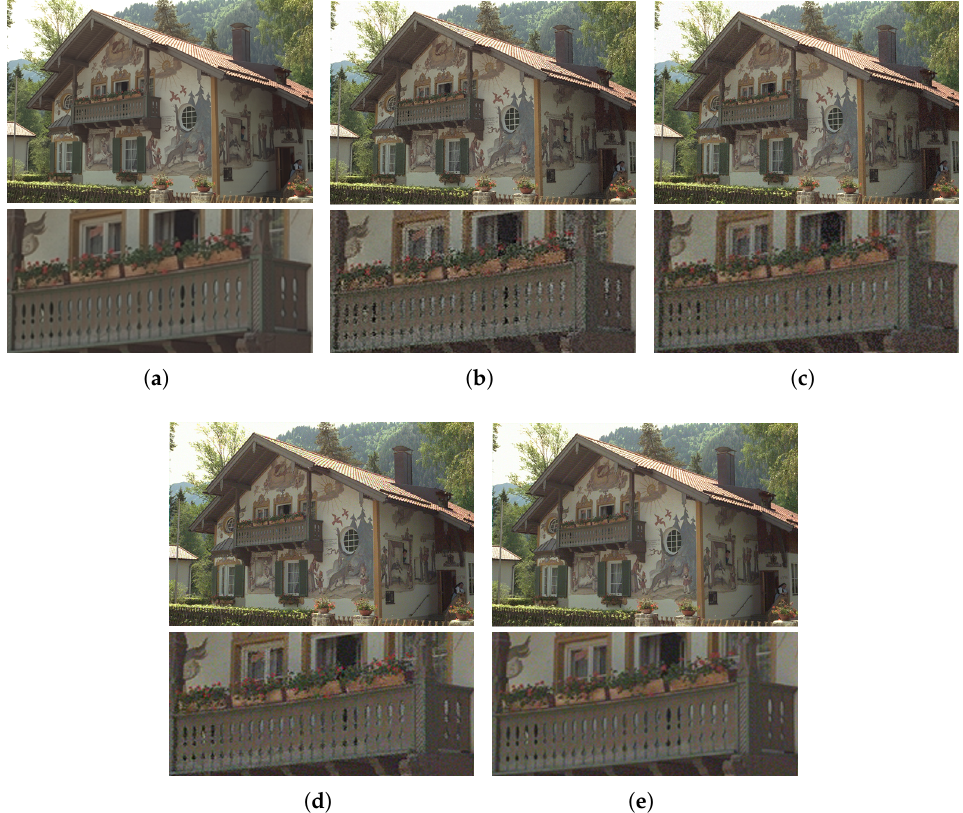
Figure 4. The comparison of contaminated images from JND models based on different proposed factors. The contaminated images have the same level of noise, with PSNR = 28.25 dB. ( a ) The original image. ( b ) The basic model JND B , VMAF = 80.10. ( c ) The model JND S based on the basic model and θ θ saliency modulation, with VMAF = 84.42. ( d ) The model JND C based on the basic model and color θ sensitivity modulation, with VMAF = 88.04. ( e ) The proposed model CSJND θ , with VMAF =